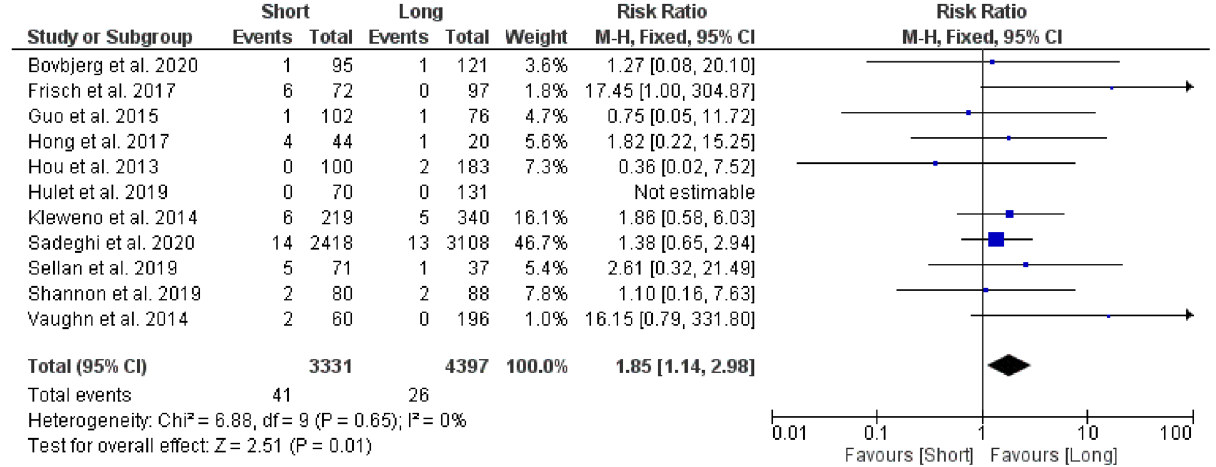
Figure 6. Forest plot of risk ratio for peri-implant fractures between long and short CMD groups. Blue boxes represent weighted mean values of each study. The black diamond represents the overall pooled weighted mean of all included studies.